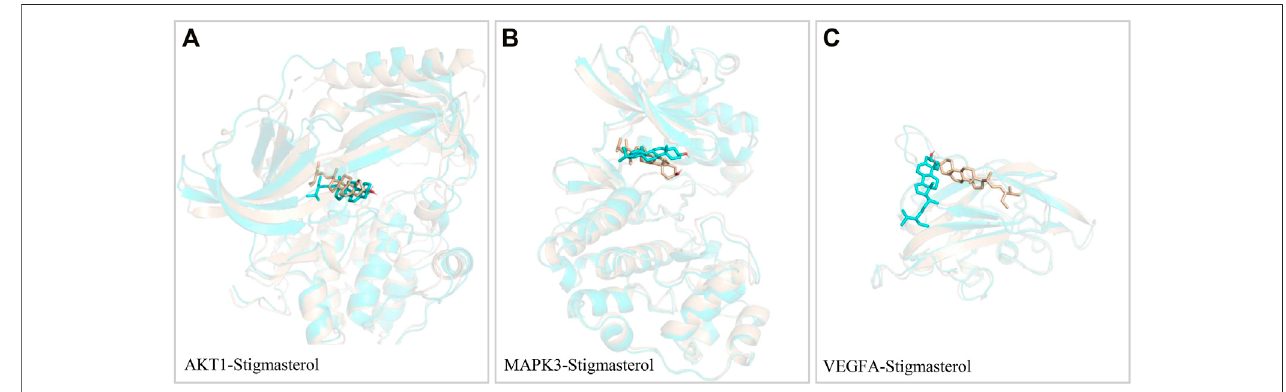
FIGURE 8 | Pose Changes in Molecular Dynamics Simulation. Wheat is the fi rst frame, cyan is the last frame.